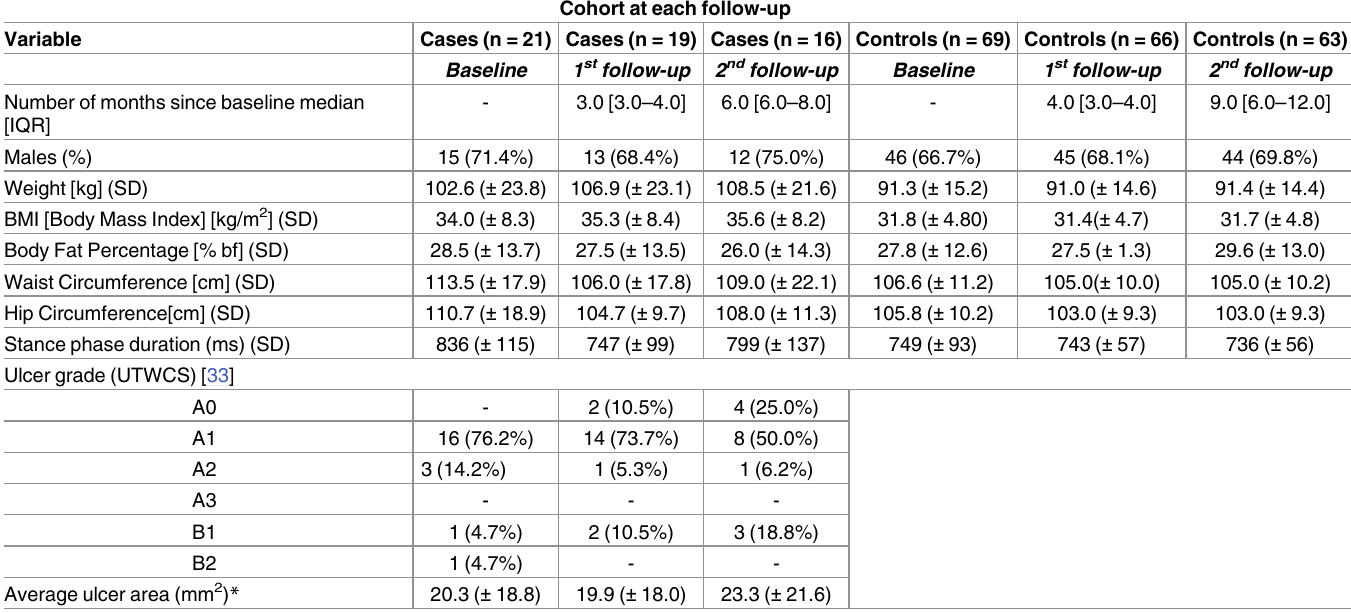
Table 2. Clinical and demographic characteristics of the study cohort at each follow-up.